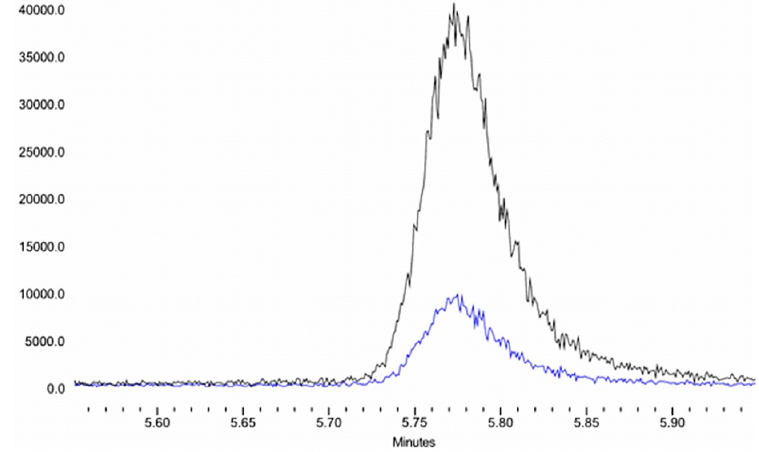
Figure 4. 5-DCB complex identified in GCB extract. Blue chromatogram represents 10 B, while the black one highlights 11 B. The ratio between the areas is approximately 1:5, which is corresponding to the specific B isotope ratio. B: Boron; 5-DCB: Diester chlorogenoborate; GCB: Green coffee bean.